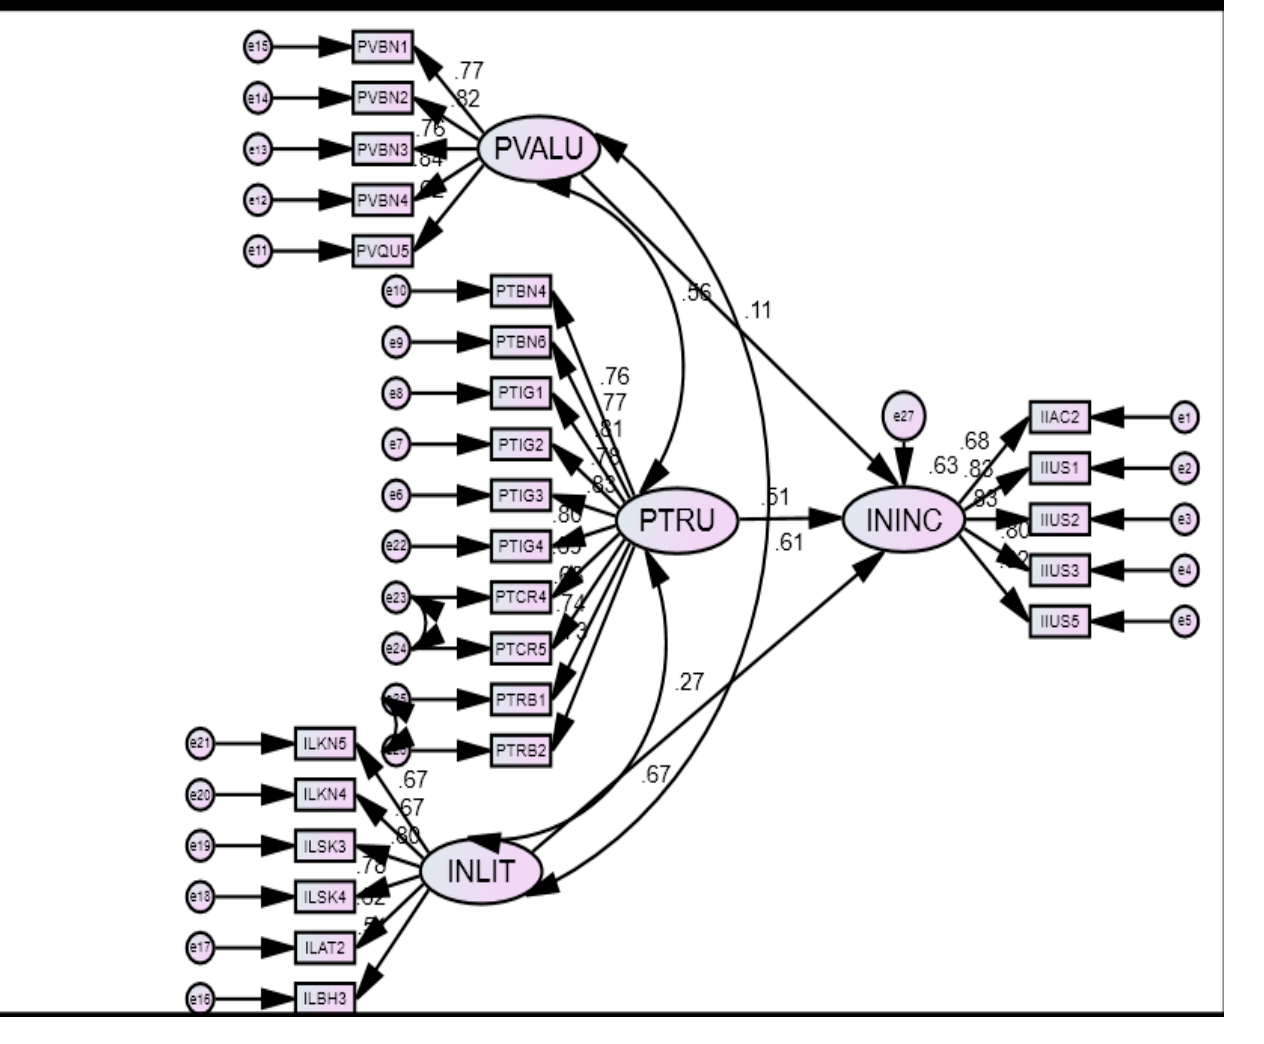
Figure 1. Structural model for insurance inclusion. Chi-Square = 665.803; Degree of